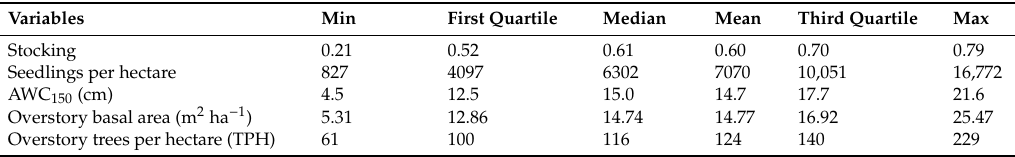
Table 3. Summary statistics of stocking of all species, seedling density of all species, available water capacity at 150 cm (AWC150), overstory basal area per hectare for all species, and overstory density for all species for the 98 compartments in 1935 that were used in the model development. The overstory basal area was calculated for all trees > 8.9 cm in diameter at breast